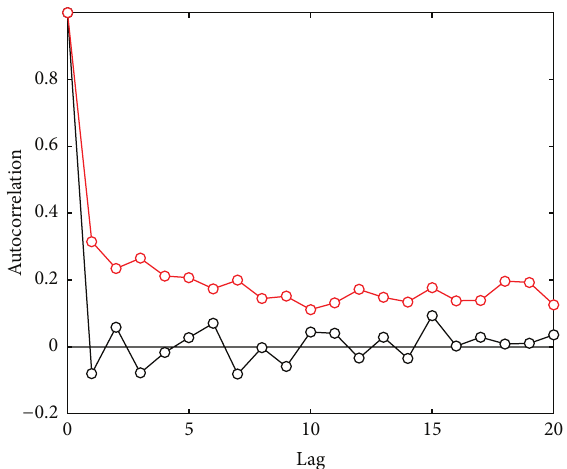
Figure 3: Autocorrelation function of the S&P 500 index. The black line shows the autocorrelation function of the returns. The red line is the autocorrelation of the absolute returns.